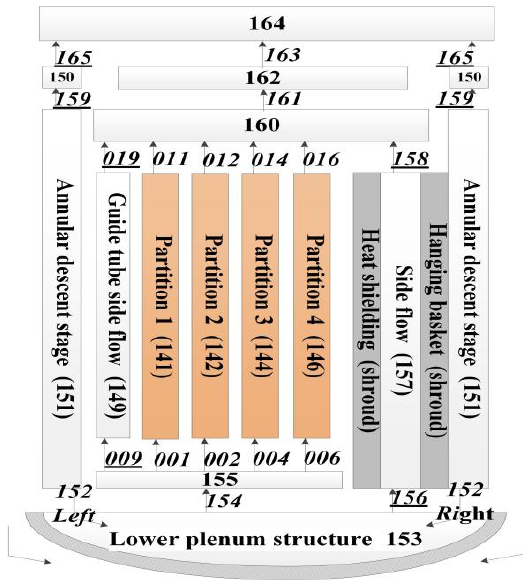
Figure 2. Analysis model of reactor core.